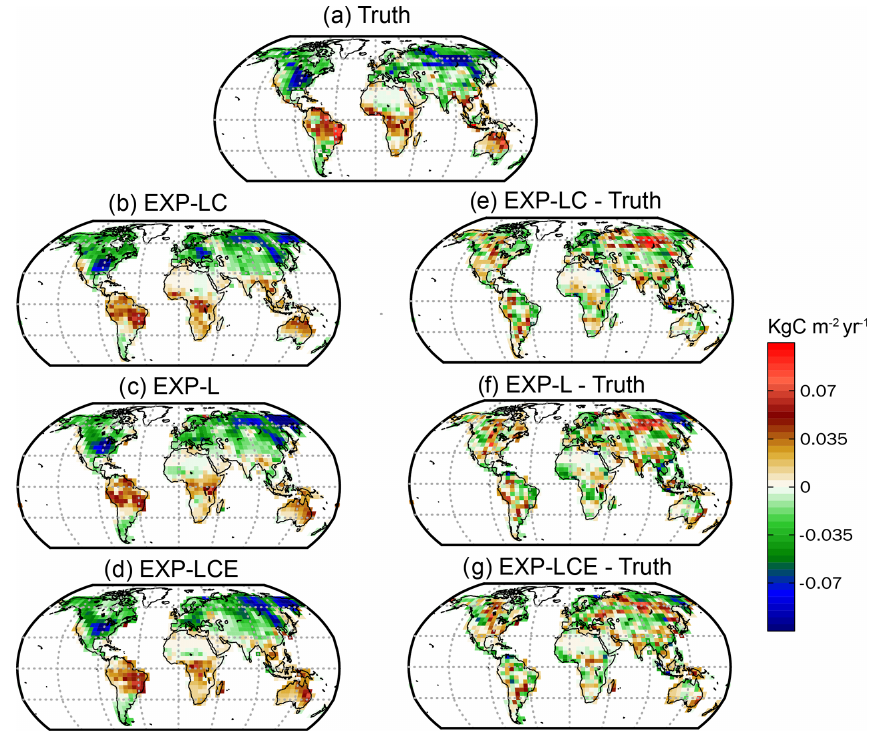
Figure 11. The spatial distribution of FTA for the truth (a) , EXP-LC (b) , EXP-L (c) , and EXP-LCE (d) averaged from January 2015 to December 2017. The annual mean of the prior FTA is not shown because it is zero at each grid. The bias of EXP-LC compared with the truth (e) , EXP-L compared with the truth (f) , and EXP-LCE compared with the truth (g) .